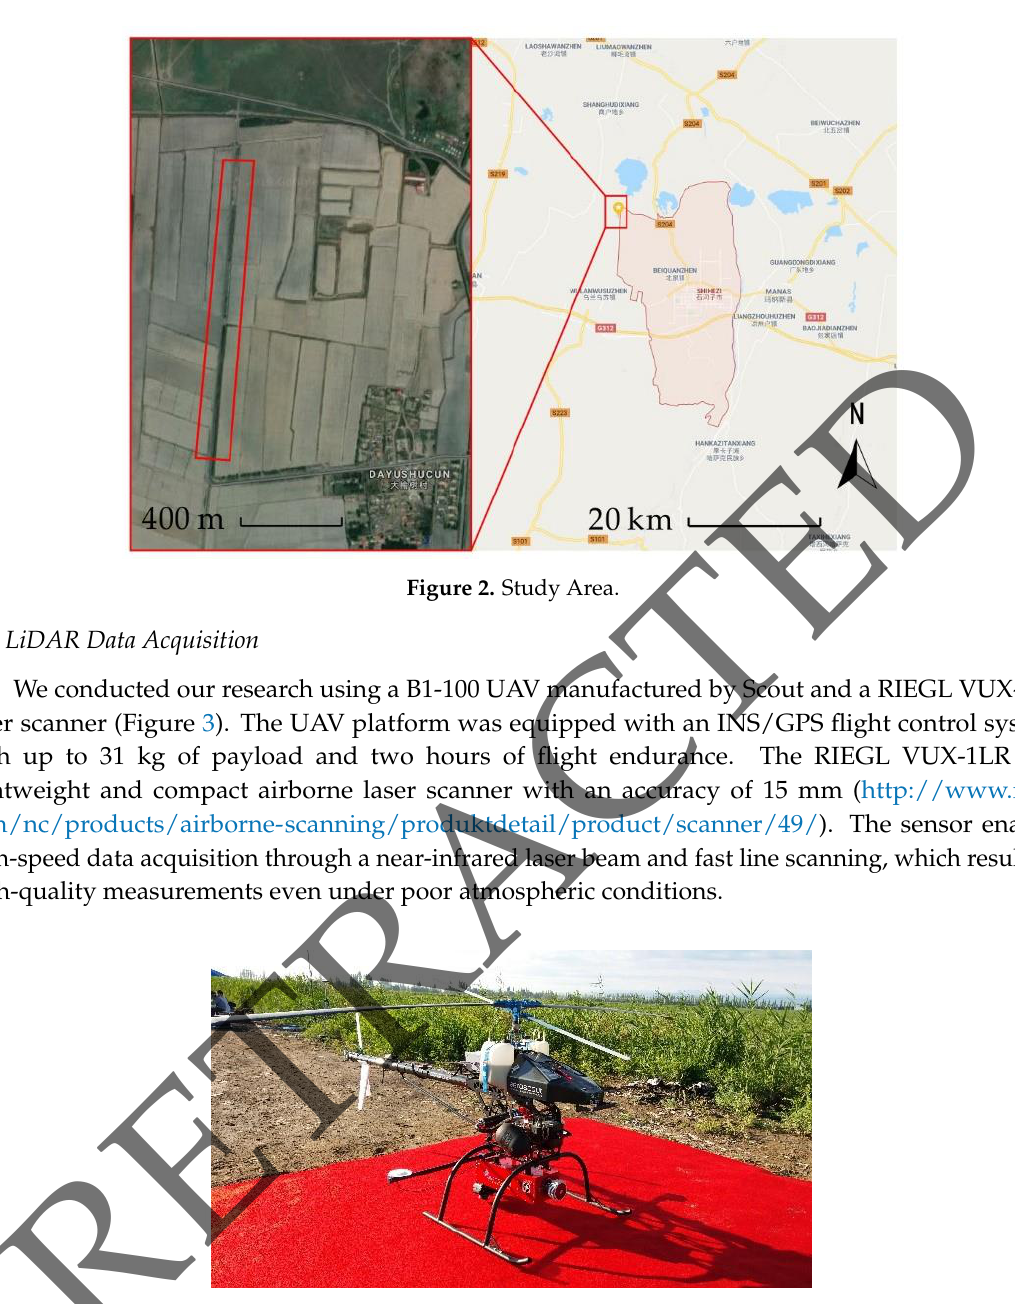
Figure 3. Light detection and ranging (LiDAR) data acquisition system.